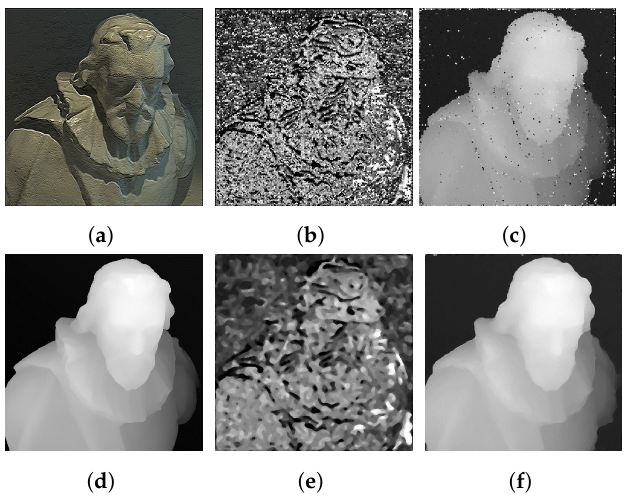
Figure 8. ( a ) Central sub-aperture image of a LF image, ( b ) unrefined depth map calculated without gradient addition, ( c ) unrefined depth map calculated with gradient addition, ( d ) ground-truth depth map, ( e ) refined depth map calculated without gradient addition and ( f ) refined depth map calculated with gradient addition. The Badpix metric for without and with gradient addition is 9.11% and 96.23%,